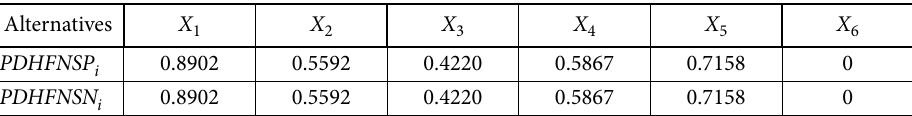
Table 12. The PDHFNSP i and PDHFNSN i Alternatives X 1 PDHFNSP i